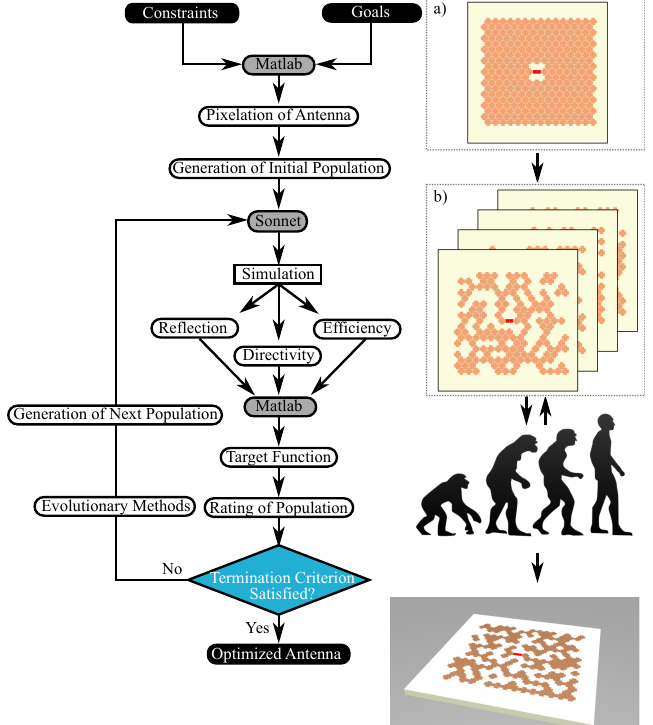
Figure 2. Flowchart of the proposed optimization technique. ( a ) First a predifined area is pixelated. ( b ) After pixelation an initial population is created with Matlab and fed into Sonnet where the antenna is simulated. The results are then handed back to Matlab and the fitness function is computed from the optimized parameters. The population is rated and if it does not meet the termination criteria, a new one is created based on the first